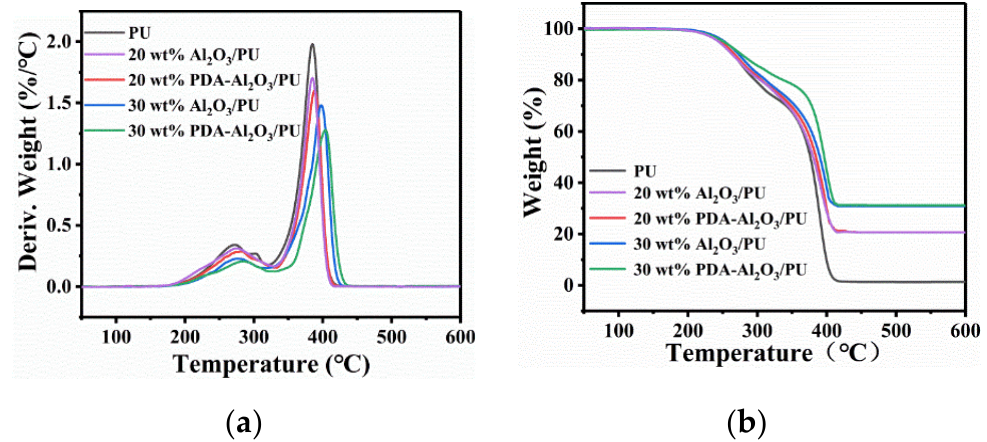
Figure 8. Thermal stability of Al 2 O 3 / PU and PDA-Al 2 O 3 / PU composites: ( a ) TG, ( b ) DTG curves. Obviously, both pure PU and composites exhibit two weight loss temperature ranges; 210–320